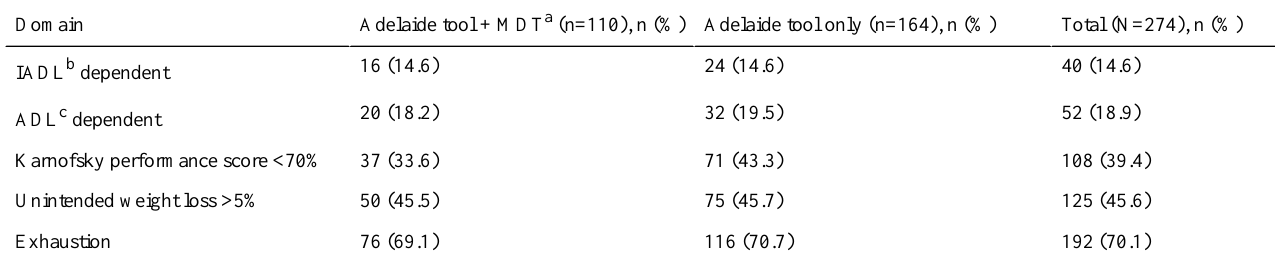
Table 2. Distribution of dependency in various functional domains among geriatric patients attending a dedicated regional cancer care center (N=274).